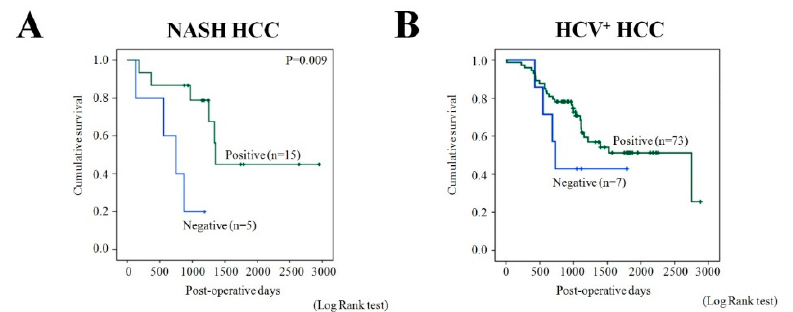
Figure 6. Association of ARG1 expression with NASH-associated ( A ) and HCV + ( B ) patients’ cumulative survival.